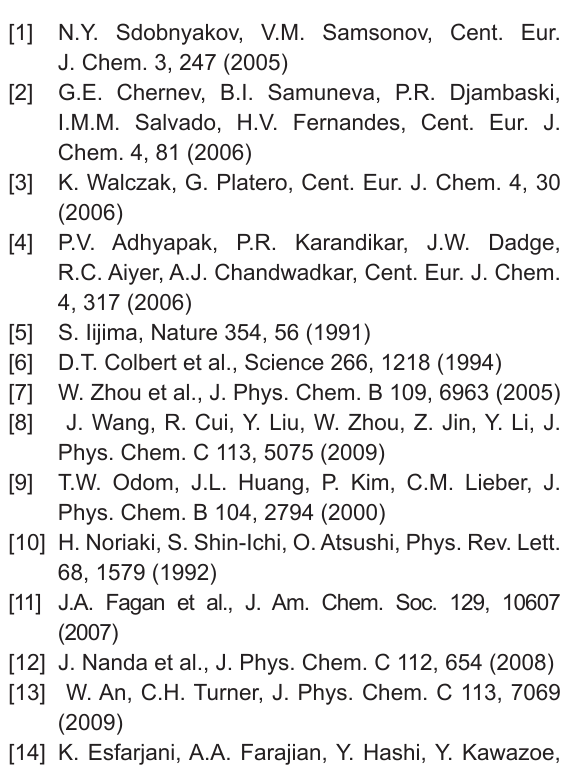
Si) at B3LYP/6-31G(d) 47